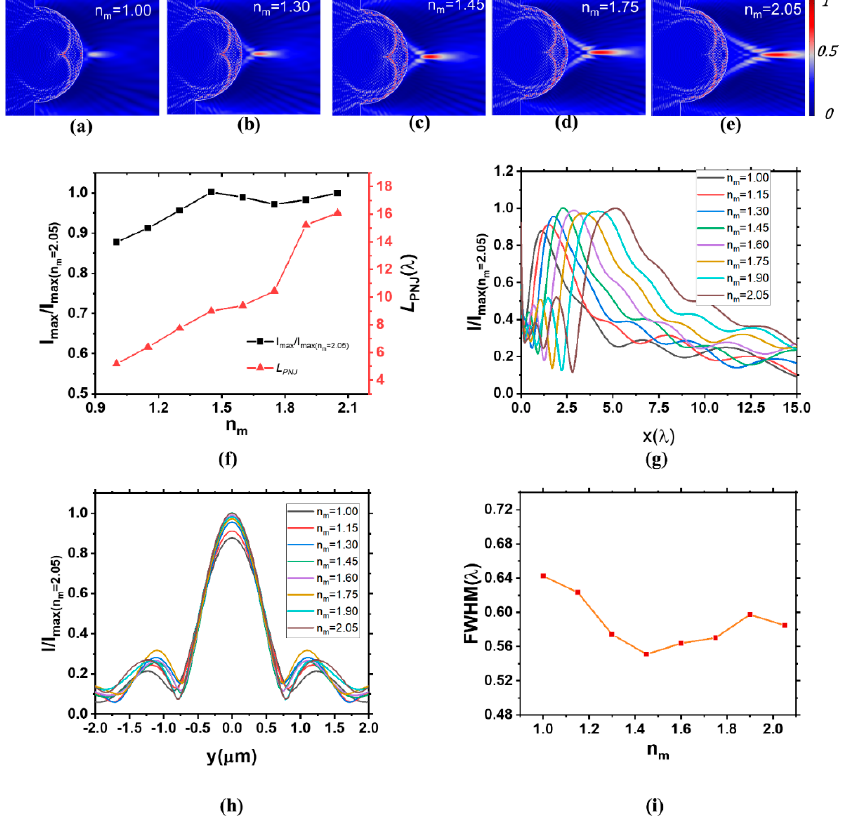
Figure 5. Intensity of electric field of PNJ with n m = 1, 1.3, 1.45, 1.75, and 2.05 ( a – e ). Maximum electric field intensity ( I max ) normalized to I max ( n m = 2.05 ) and L PNJ ( f ). Electric field intensity relative to I max of n m = 2.05 along the length of PNJ ( g ). I / I max across the PNJ waist is shown in ( h ). FWHM of the PNJs as a function of surrounding refractive index is shown in ( i ).